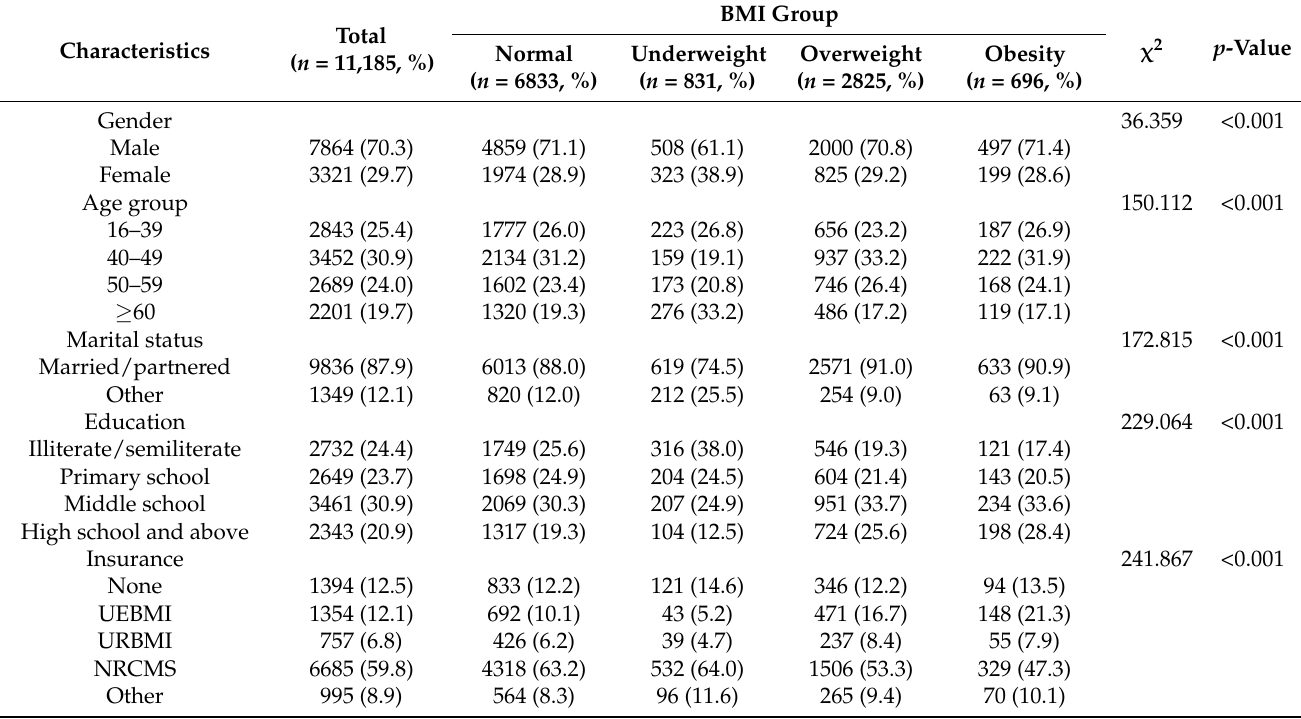
Table 1. Distribution of baseline characteristics among participants with different BMI